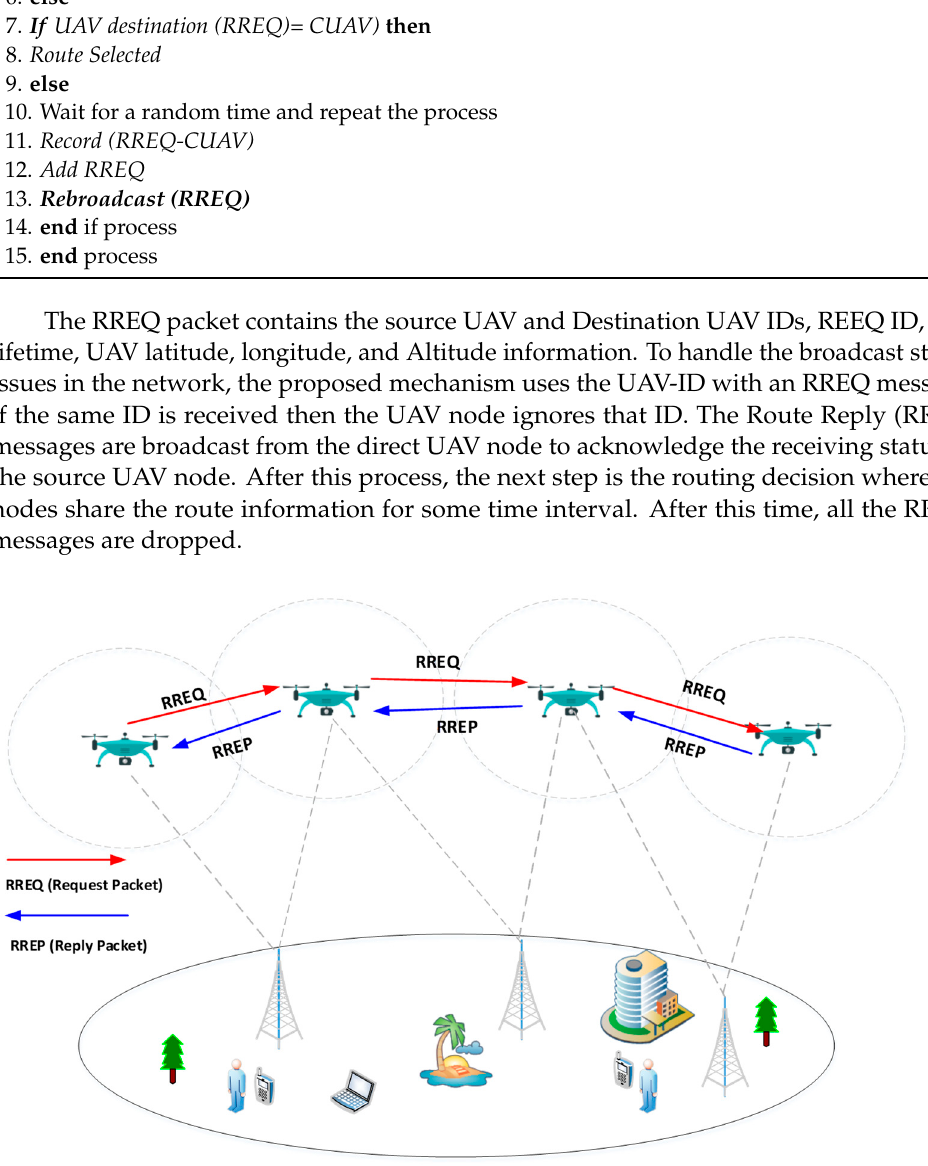
Figure 5. RREP Process at UAV-to-UAV.